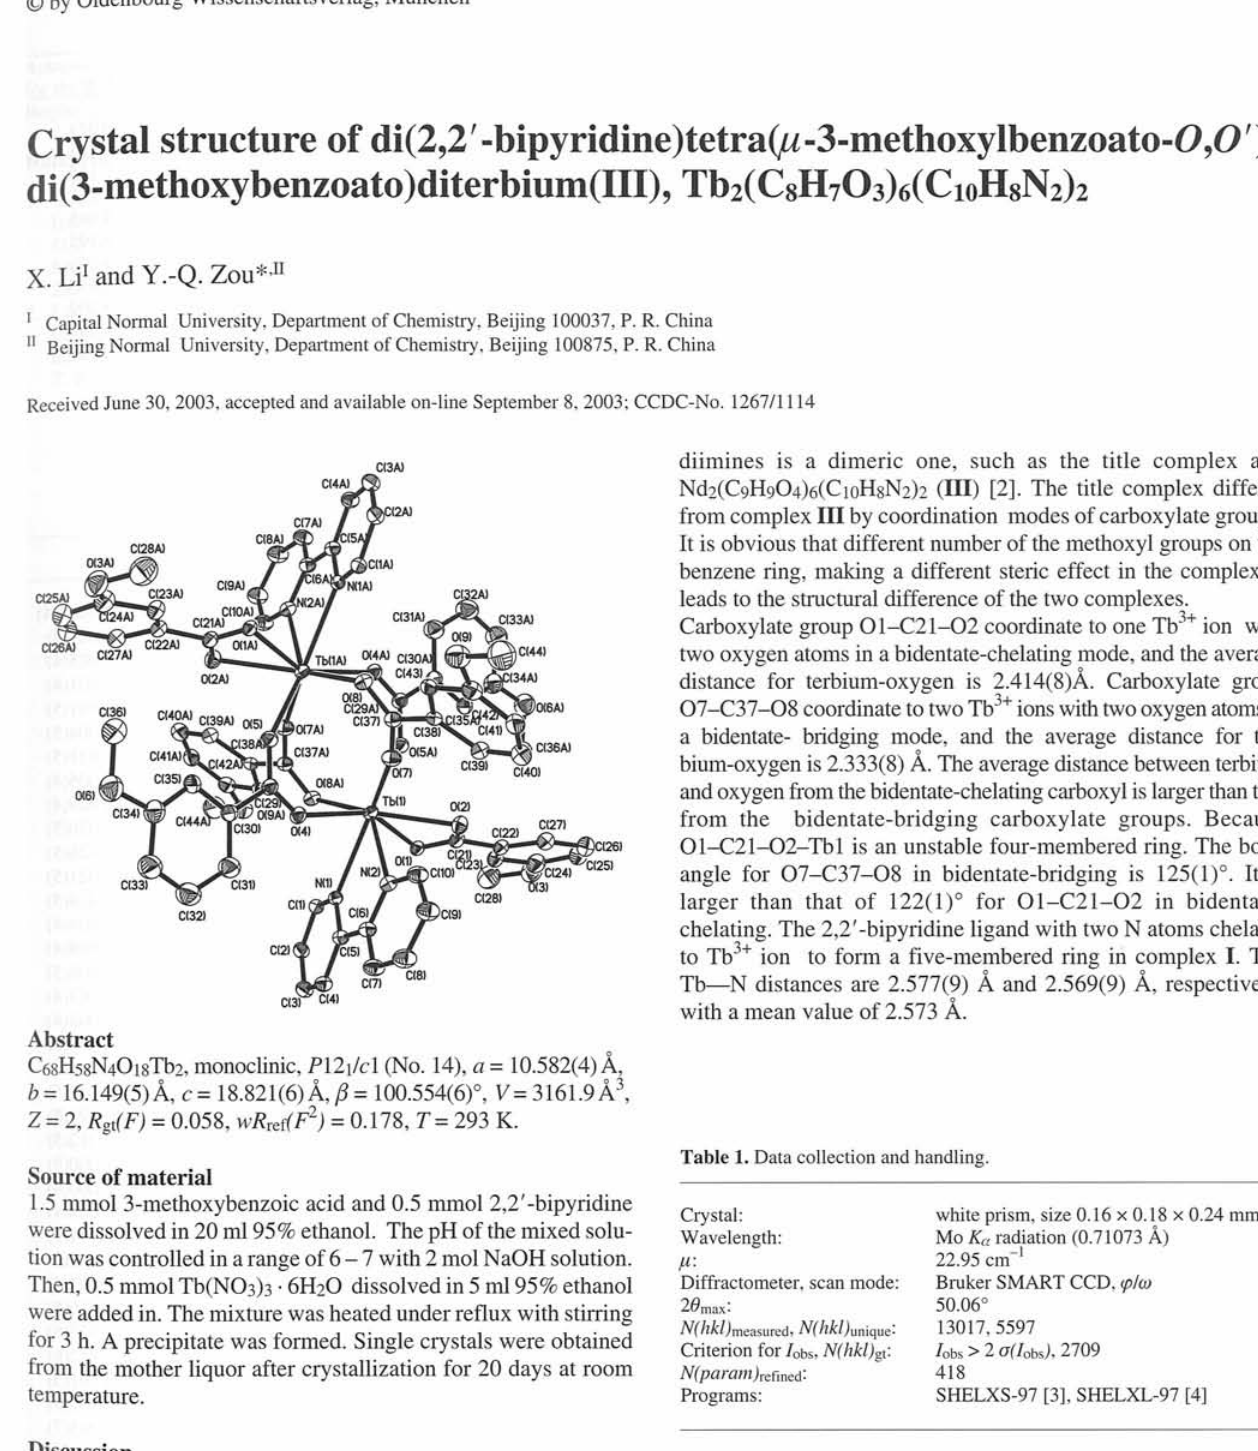
Table 2. Atomic coordinates and displacement parameters (in Á 2